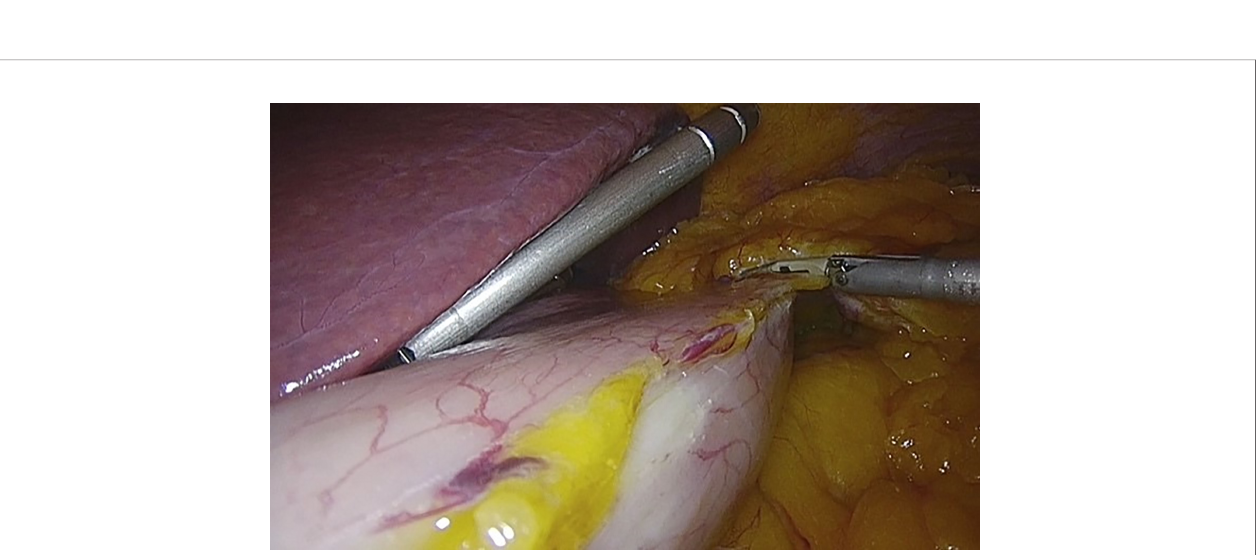
FIGURE 3 | Gastrojejunal anastomosis. Taken from the General Surgery and Digestive System Service, Hospital Royo